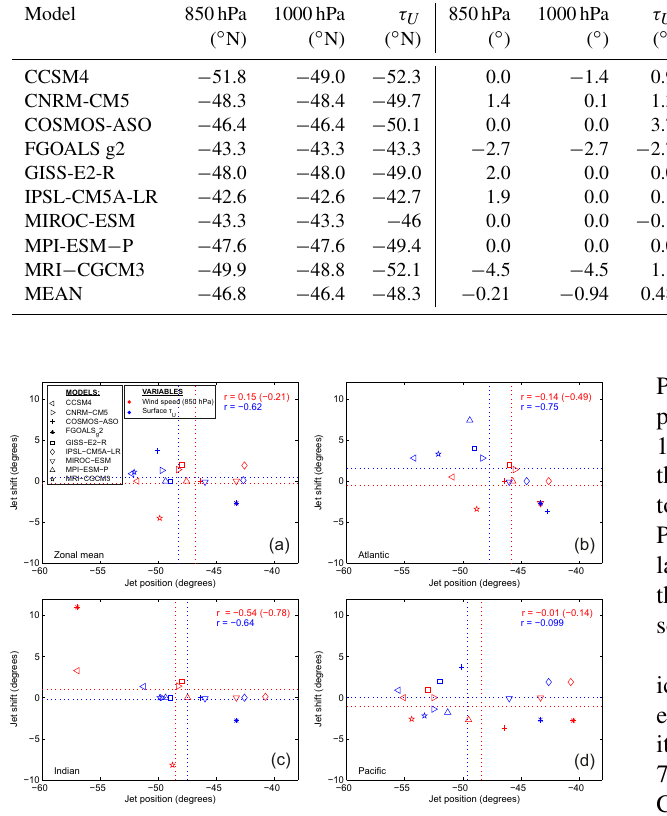
Figure 2. The state dependence of jet latitudinal shifts. (a) Scatter plot of PI annual mean Southern Ocean jet position versus LGM minus PI change in the CMIP5-PMIP3 models. (b) , (c) , and (d) show the same but for individual ocean sectors: Atlantic, Indian, and Pacific, as marked. The Atlantic sector is defined as 290 to 20 ◦ , the Indian as 20 to 150 ◦ , and the Pacific as 150 to 290 ◦ . In- dividual symbols indicate individual models, as marked in the leg- end in panel (a) . The jet is defined using the zonal 850hPa wind speed (red) and surface shear stress (blue). Dashed lines indicate the model mean position and model mean shift for each panel. Speci- fied r values indicate the correlation coefficient; bracketed 850hPa r values are calculated excluding the MRI-CGCM3 model. Corre- lation coefficients and relationships using 1000hPa “surface wind speeds” are almost identical to those using